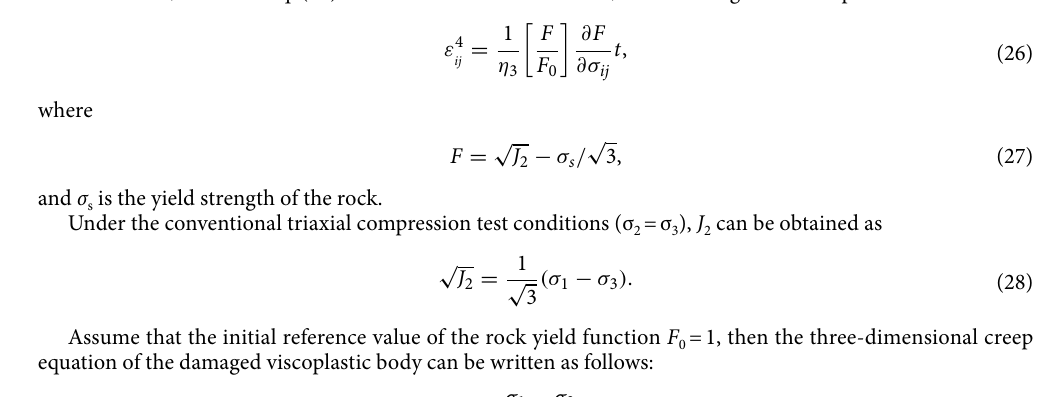
According to the series character